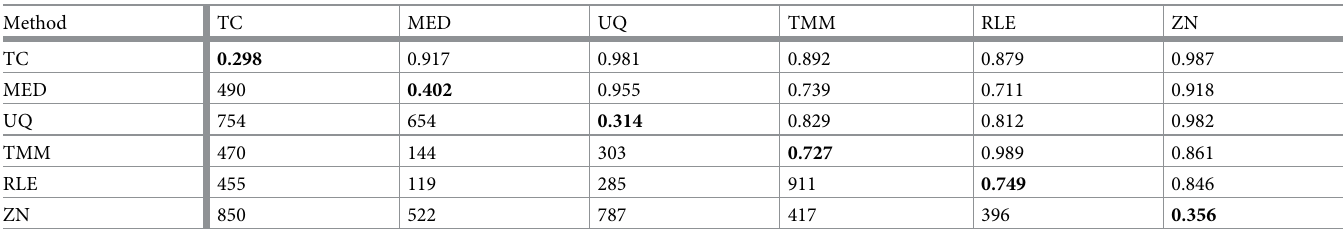
Table 3. Agreement among different normalization